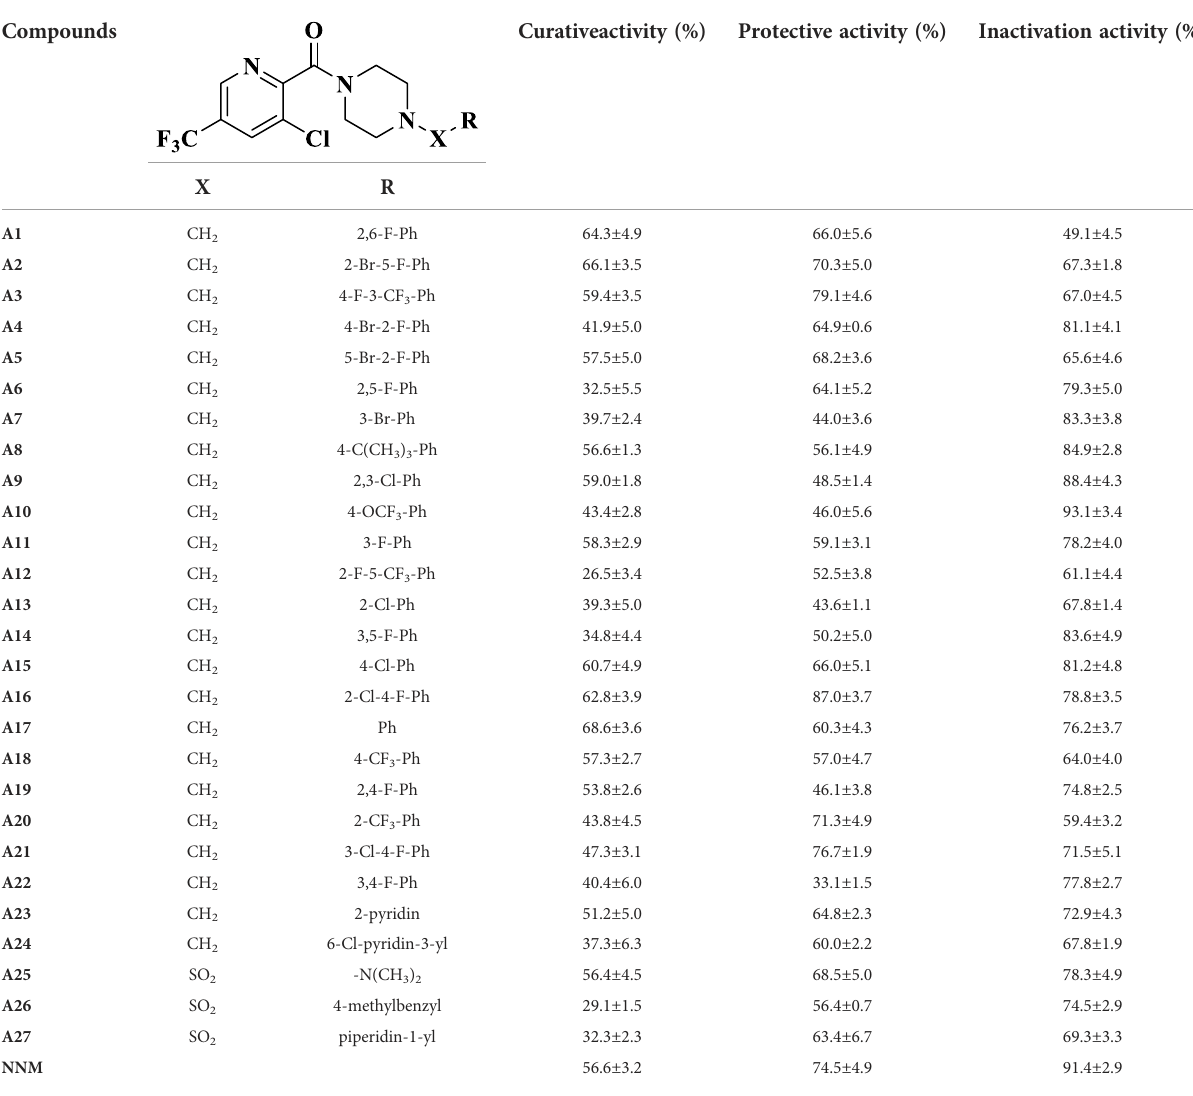
TABLE 1 Activity of compounds A1 – A27 on TMV. Compounds Curativeactivity